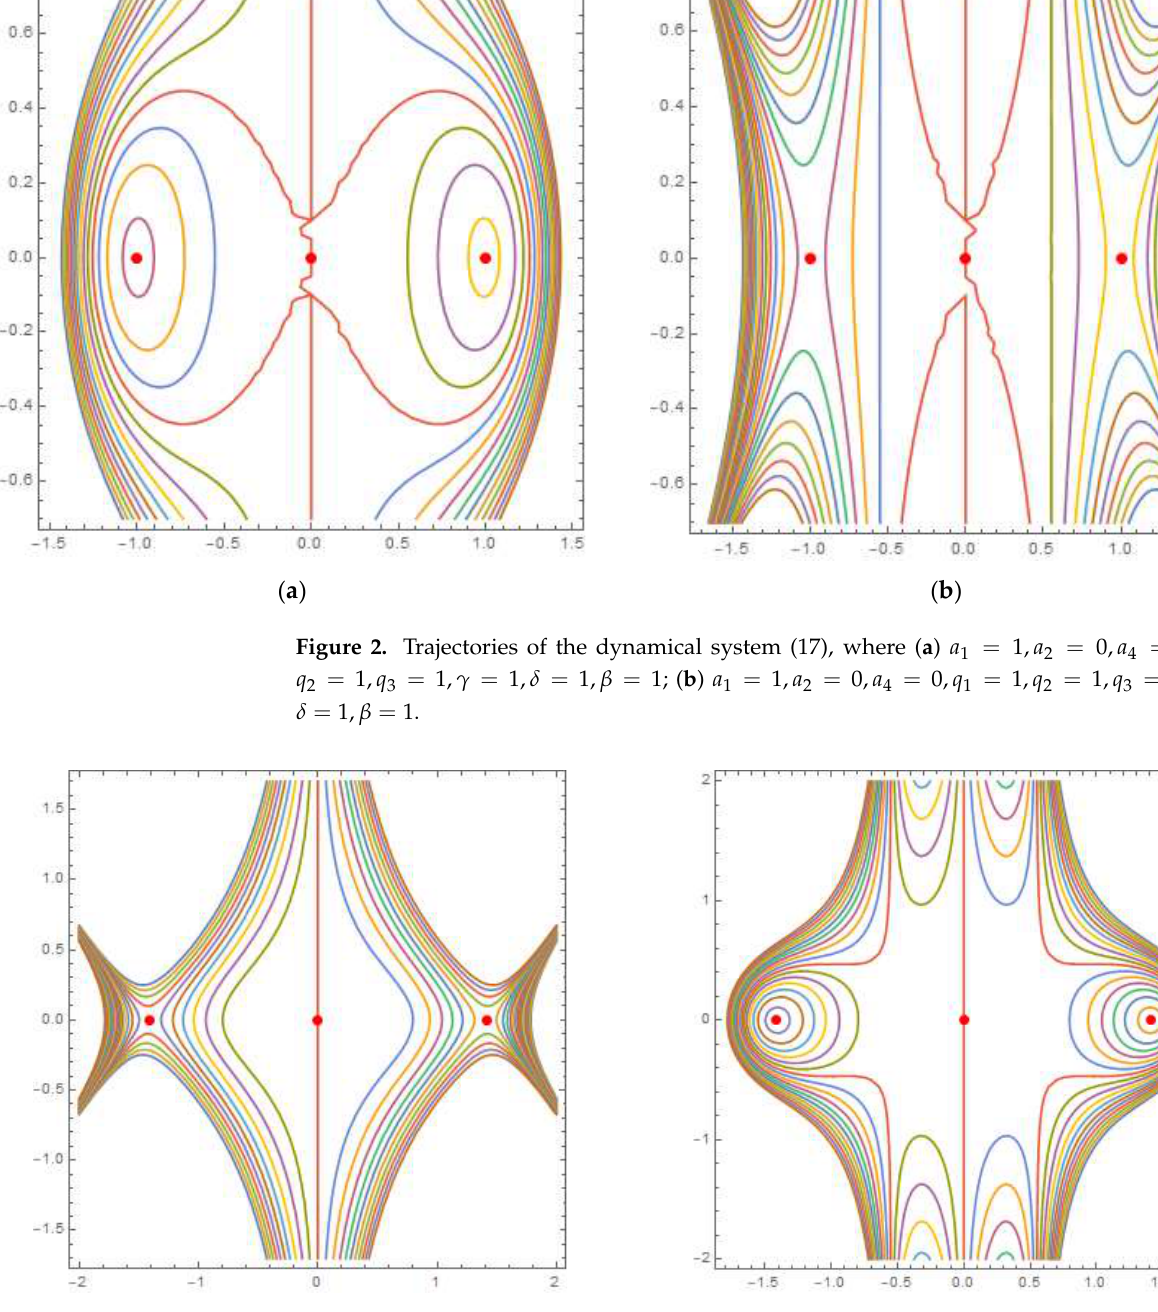
= 2, 𝑞 = 1 2 = 1, 𝑎 = 0, 𝑎 = 0, 𝑞 = 2, 𝑞 = −1, 𝑞 = −1, 𝛾 = −1, 𝛿 = = 1, a = 0, a = 0, q = 2, q = − 1, q = − 1, γ = − 1, 1 2 4 1 2 3 2 2 3 1 4 1